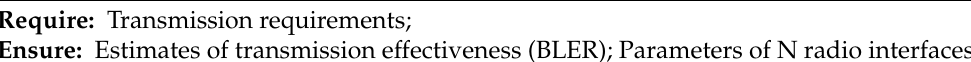
Figure 1. The block diagram of the data allocation algorithm for selecting the optimal radio link in the heterogeneous node. Algorithm 1 Pseudocode of the data allocation